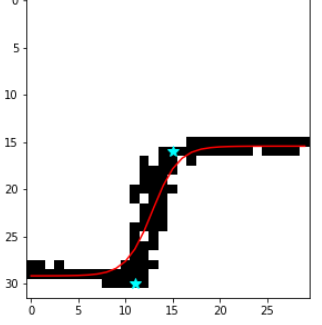
Figure 4: Vectorization of a curb with sigmoid curve